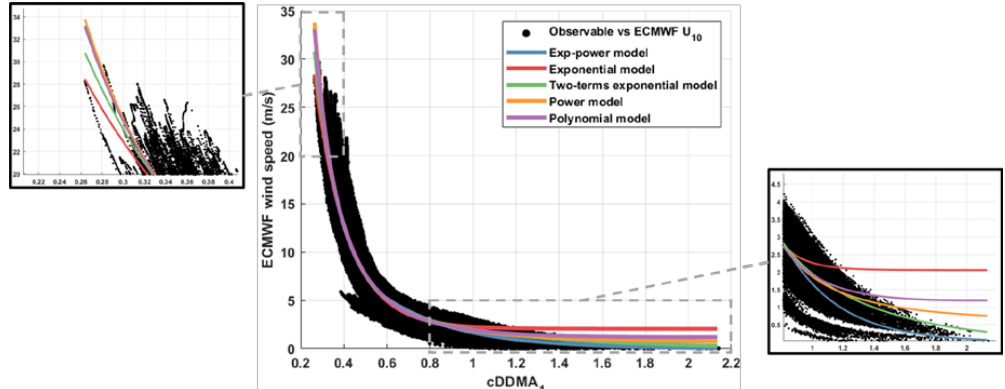
Figure 9. The composite delay-Doppler map average cDDMA 1 plotted against the ECMWF wind speed for the training data and the corresponding fit curve for different models. To clearly compare the performance of wind retrieval between models, we calculate the mean errors and root-mean square (RMS) error using wind speed intervals of width ±1 m/s, as shown in Figure 10. It is shown that the retrieving accuracy and precision between different models are comparable to each other. However, the performance of the dual model is slightly better than other models in low wind speeds, no matter in terms of mean error or RMS error. Thus, in Section 3, we conducted the performance evaluation using the dual model on different observables.